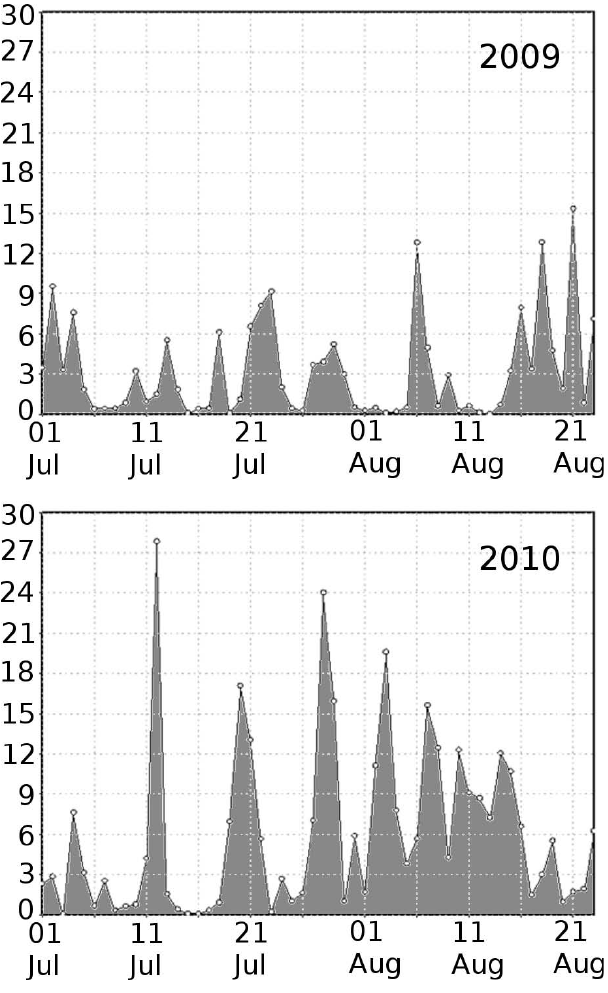
Fig. 2. Daily rainfall (mm) across the Pakistan region (Lat. 28 ◦ N– 35 ◦ N, Long. 70 ◦ E–74 ◦ E) in July/August 2009 (above) and 2010 (below). Reproduced from GESDISC (2011).